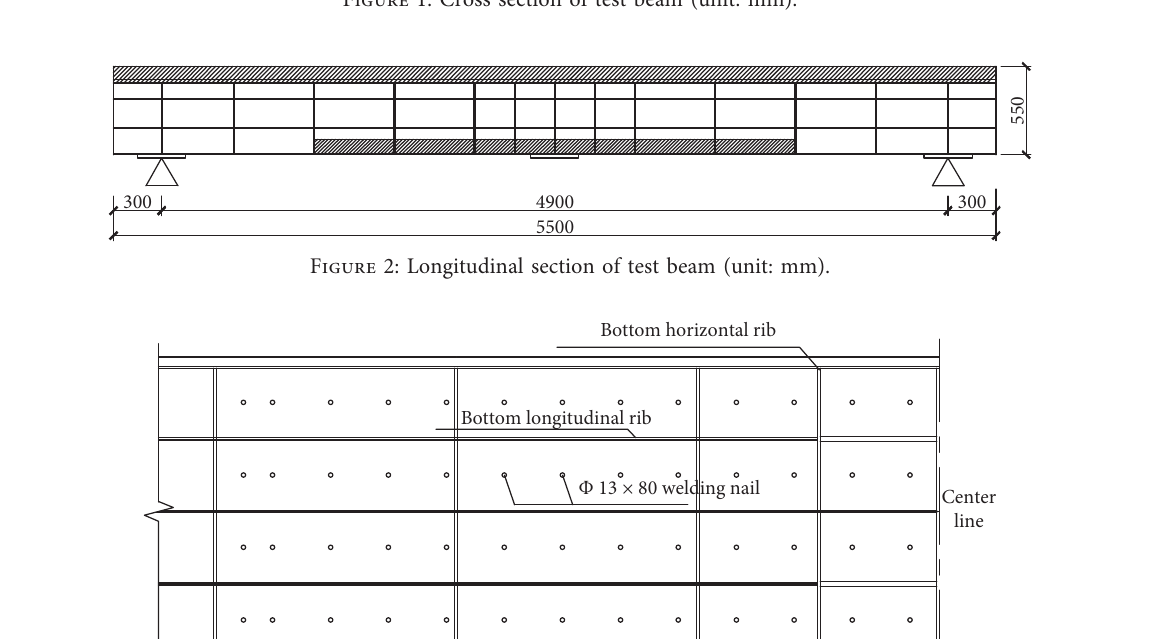
Figure 1: Cross section of test beam (unit: mm).